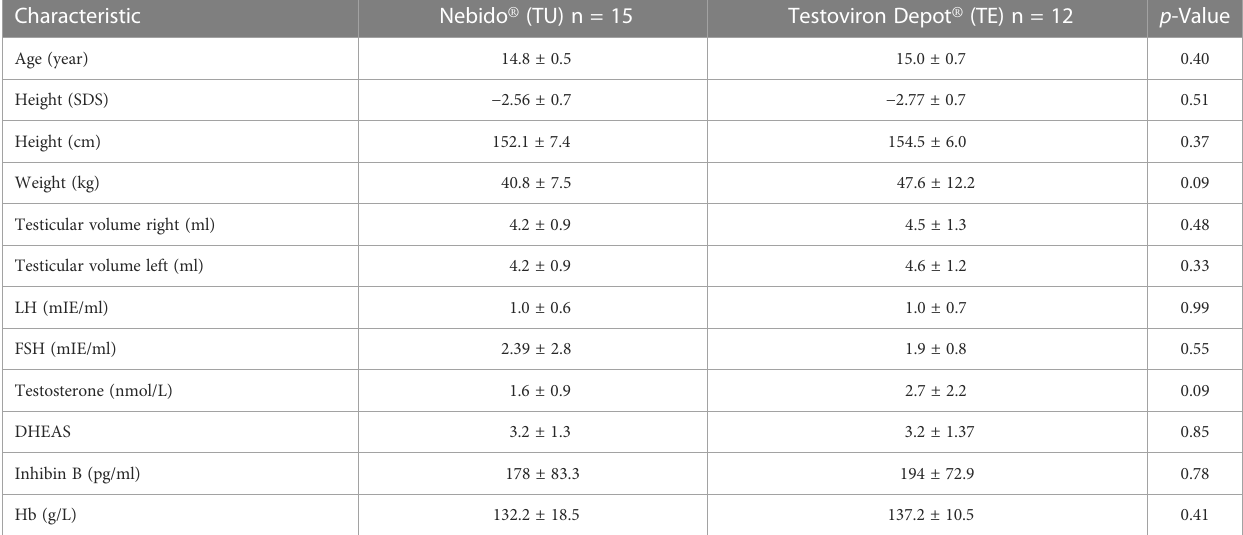
TABLE 1 Baseline characteristics of the boys treated with Nebido ® and Testoviron Depot ®